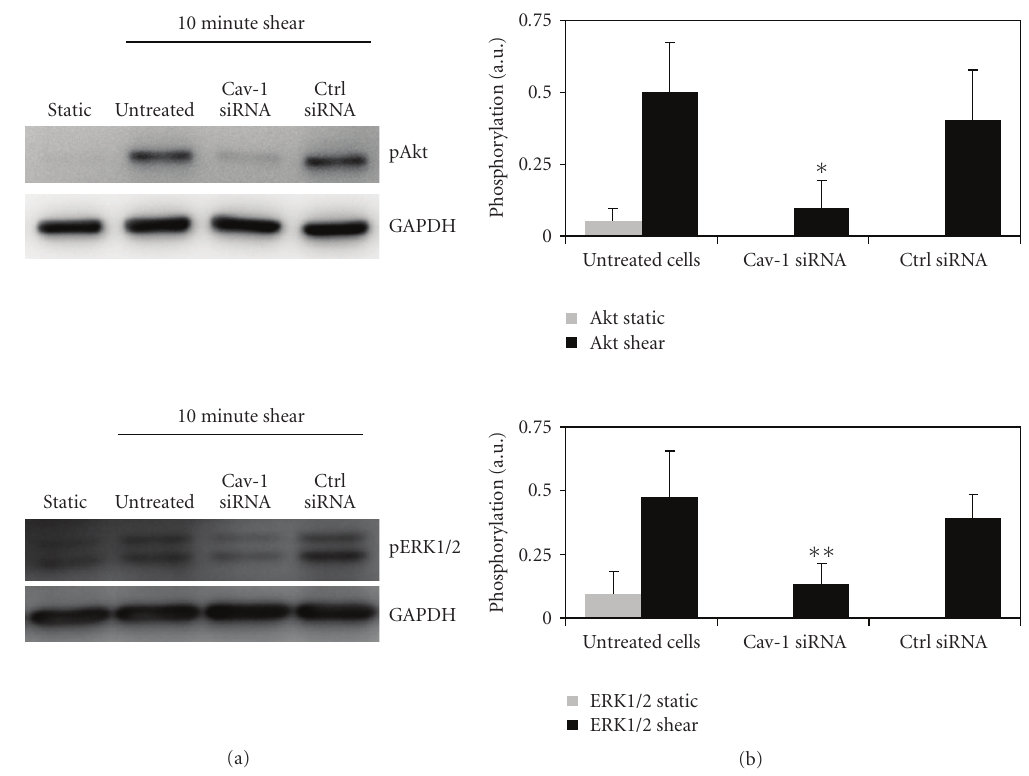
Figure 3: Activation of Akt and ERK1/2 in response to shear stress. HUVECs were transfected with either caveolin-1 siRNA, negative control siRNA, or left untreated. 48 hours after transfection, cells were subjected to a shear stress of approximately 15 dyn/cm 2 for 10 minutes. (a) After treatment, cells were lysed, and the amount of phosphorylated Akt and ERK1/2 was determined by immunoblotting. Equal loading of proteins of each transfection condition was ensured by detecting the unrelated metabolic enzyme GAPDH on the same blot. The phosphorylation status of statically cultured cells is shown as a reference. (b) Quantification of the signal intensities in the immunoblot assay. Each bar represents the average intensity of four separate experiments. Error bars denote standard deviation. Akt and ERK1/2 phosphorylations increase five- to tenfold when untreated cells are subjected to shear stress. Both Akt and ERK1/2 phosphorylations are significantly lower ( ∗ P < . 05, ∗∗ P < . 01, Student’s t -test) when cells are treated with caveolin-1 siRNA instead of negative control siRNA prior to subjecting the cells to shear stress. No significant di ff erence was detected between untreated cells and cells transfected with negative control siRNA, showing that the transfection procedure itself has no influence. Graphs represent the averages of four separate experiments.